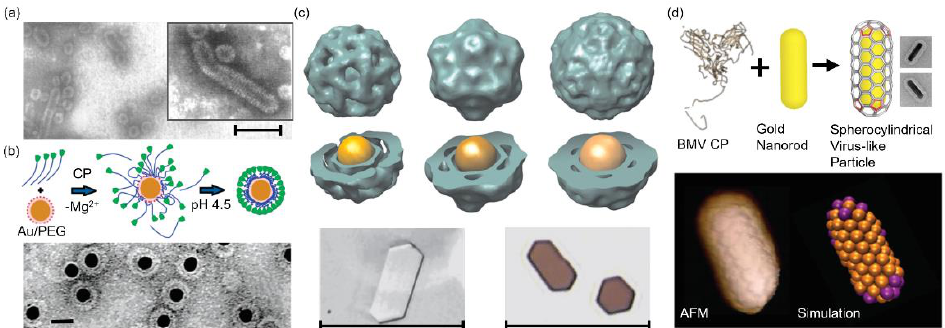
Figure 2. BMV VLPs assembled around diverse templates. ( a ) TEM images of BMV rod-like particles templated by a calf thymus dsDNA. Scale bar: 100 nm. Reprinted from [33]. Copyright (1969) with permission from Elsevier. ( b ) Top panel: The proposed BMV VLP formation templated by carboxylate-modified AuNPs. Bottom panel: A representative TEM image of BMV VLPs encapsulating 12 nm AuNPs. Scale bar: 20 nm. Reprinted with permission from [35]. Copyright (2006) American Chemical Society. ( c ) Top and middle panel: 3D reconstructions of BMV VLPs templated by AuNPs of different sizes (from left to right: 6, 9 and 12 nm). Bottom panel: transmission optical images of (left) R3BMV crystals and (right) VLP 12 crystals. Scale bar: 100 μm. Reprinted with permission from [36]. Copyright (2007) National Academy of Sciences. ( d ) Top panel: Schematic illustration and TEM images of BMV VLPs formed around gold nanorods. Bottom panel: The structure imaged by AFM and the corresponding simulated structure. Reprinted with permission from [37]. Copyright (2018) American Chemical Society.